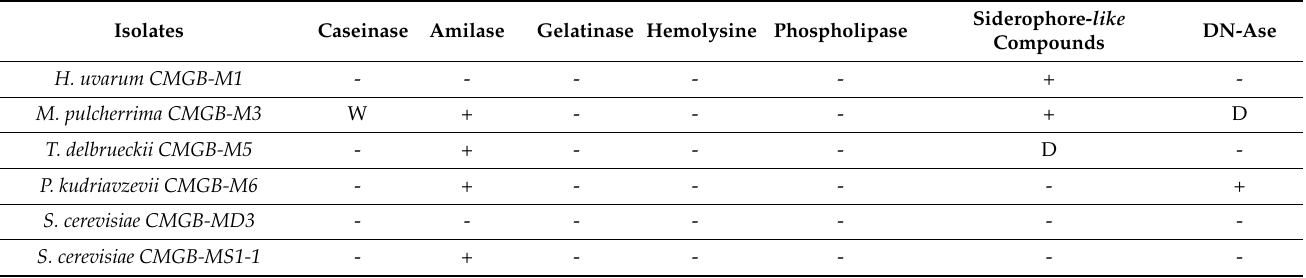
Table 4. Evaluation of the ability to produce soluble virulence